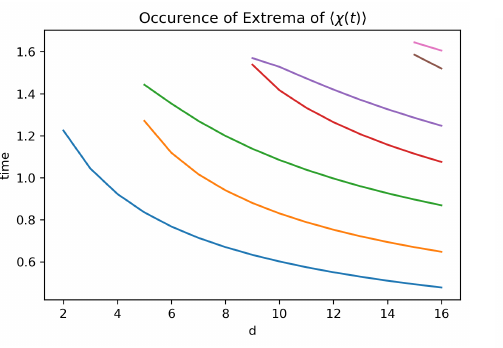
Figure 14: Comparison of 〈 χ ( t ) 〉 to 〈 χ ( t ) 〉 , the former over the GUE and P the latter over Poisson energy